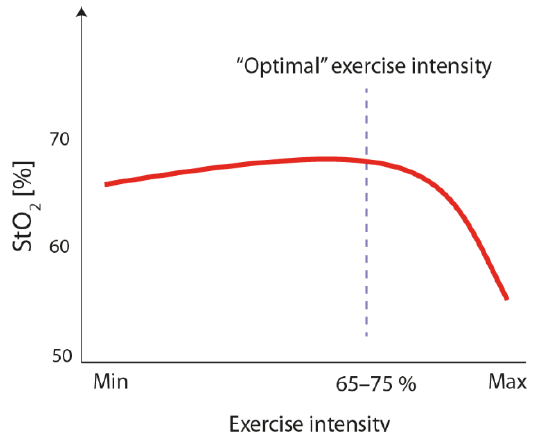
Figure 2. Schematic illustration of the time course of StO 2 during a graded exercise test to exhaustion. The optimum is tentatively defined as the lowest exercise intensity leading to the highest cerebral oxygenation (marked by the dashed line).